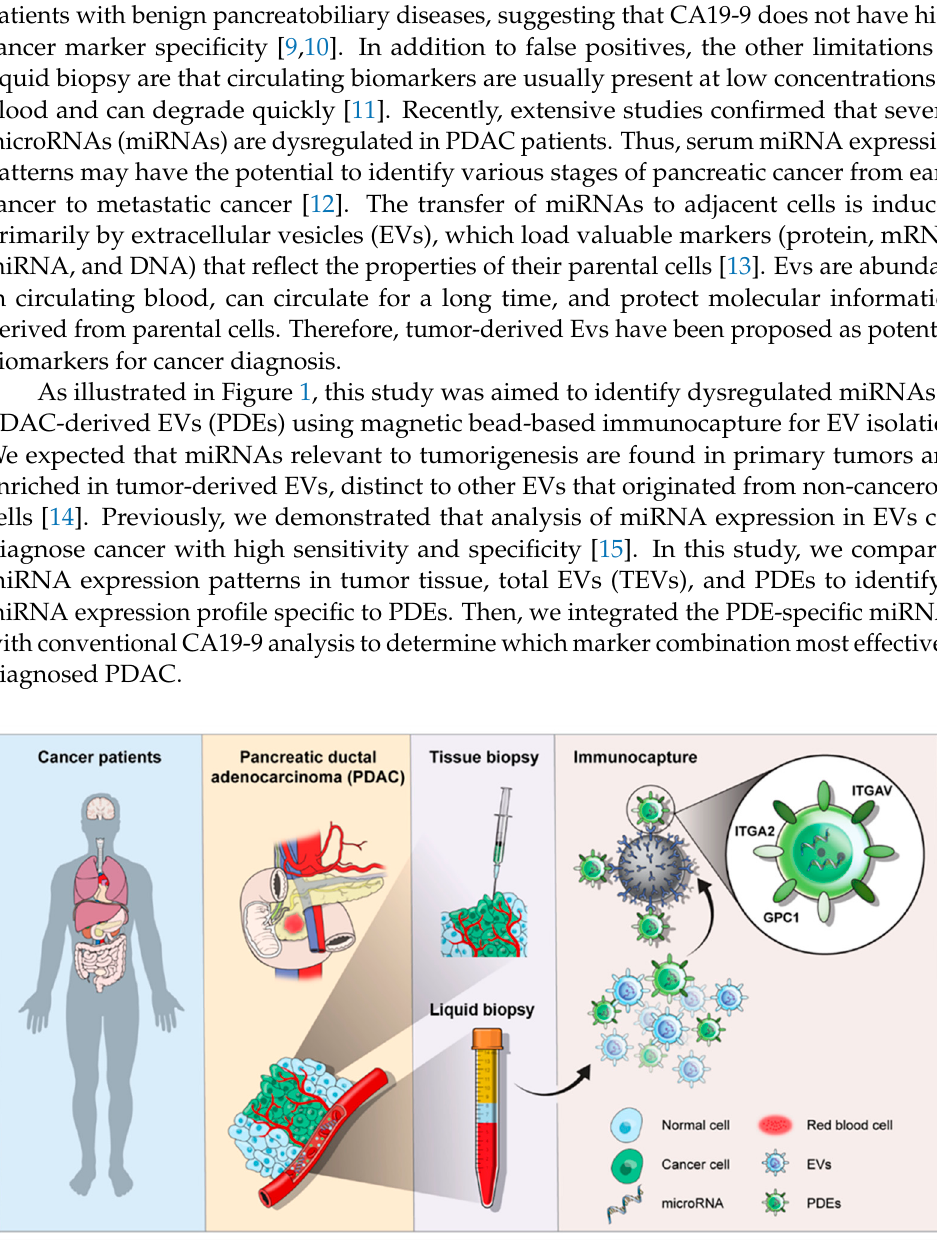
Figure 1. Schematic illustration of the clinical utility of EVs in liquid biopsy for the diagnosis of